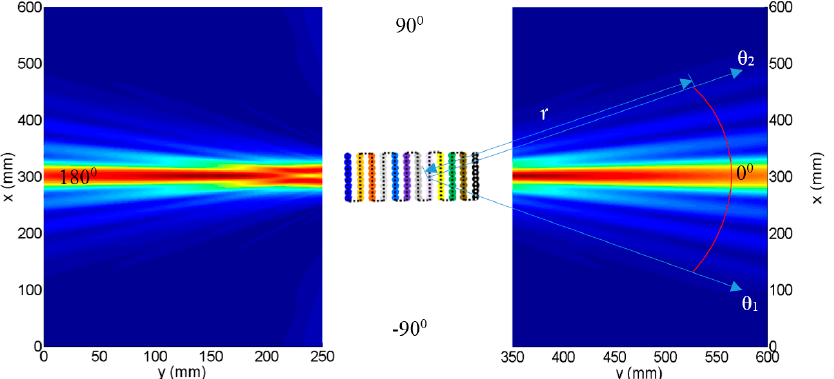
Figure 13. The radiation pattern of Rayleigh waves generated by the meander-line-coil EMAT. Reproduced with permission from [18], Elsevier, 2017.